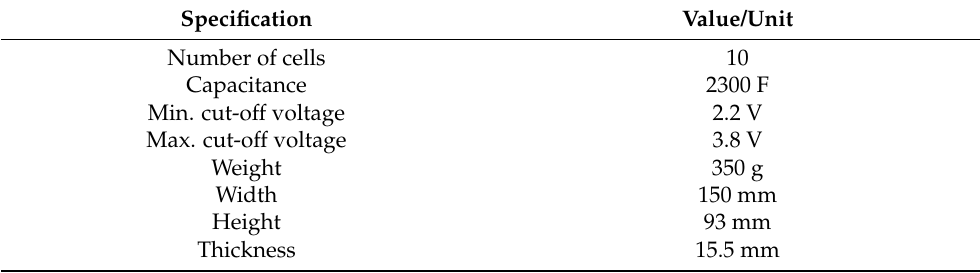
Table 1. Specifications of the target cells used in the test bench.